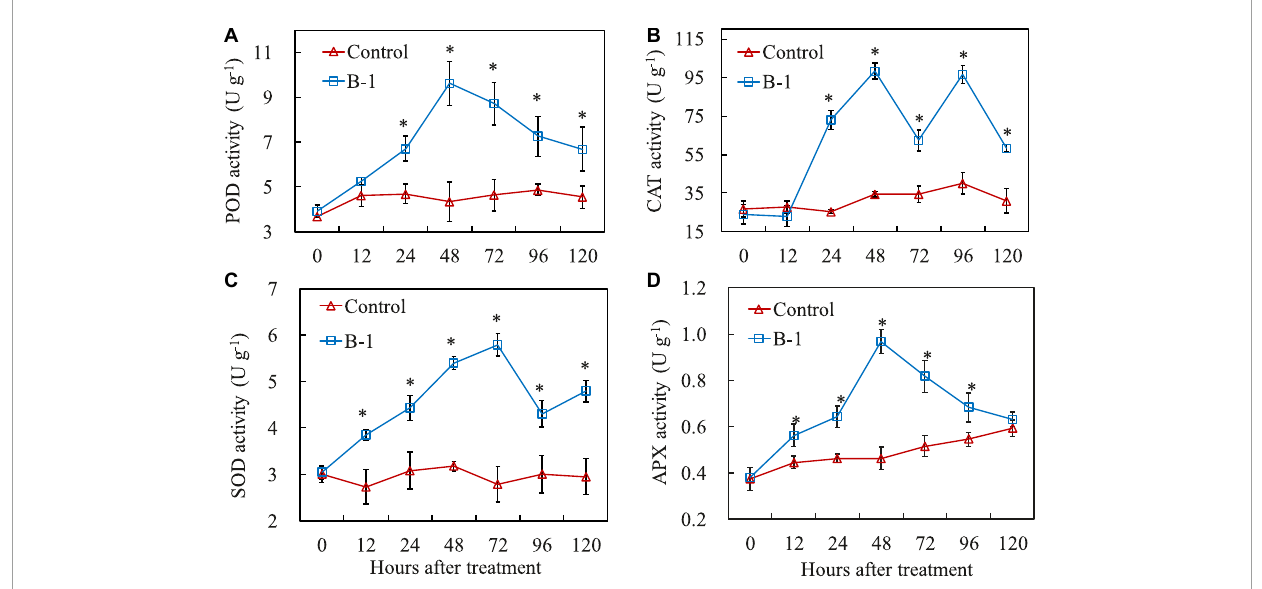
FIGURE5 The activities of POD (A) , CAT (B) , SOD (C) , and APX (D) in apple fruit treated with P. syringae B-1 at 1 × 10 8 CFU mL– 1 stored at 25 ◦ C. Each data represents the mean ± SD of three replicates. Asterisks ( ∗ ) denote a significant difference ( p < 0.05) between the strain B-1 treatment and the control apple fruit at the same time point.